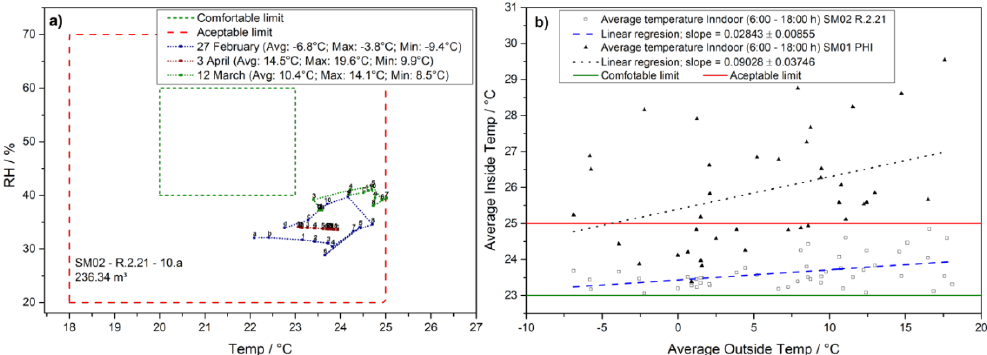
Figure 5. ( a ) Representation of the thermal comfort, taking into account temperature and relative humidity and its evolution during exemplary days, including a vacation day on 3 April 2018. Notably, good thermal comfort is never achieved because of too much heating during the winter season. ( b ) The correlation between inside and outside temperature are shown: A class room facing south (e.g., PHI) exceeds the acceptable limit of 25 °C in the majority of days, unlike class rooms facing north (e.g., R.2.21), due to more pronounced influence of heating by the